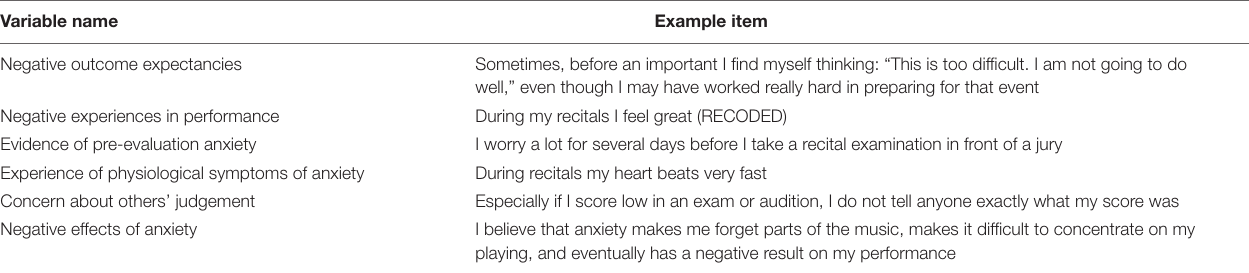
TABLE 2 | Variables included in section C of the